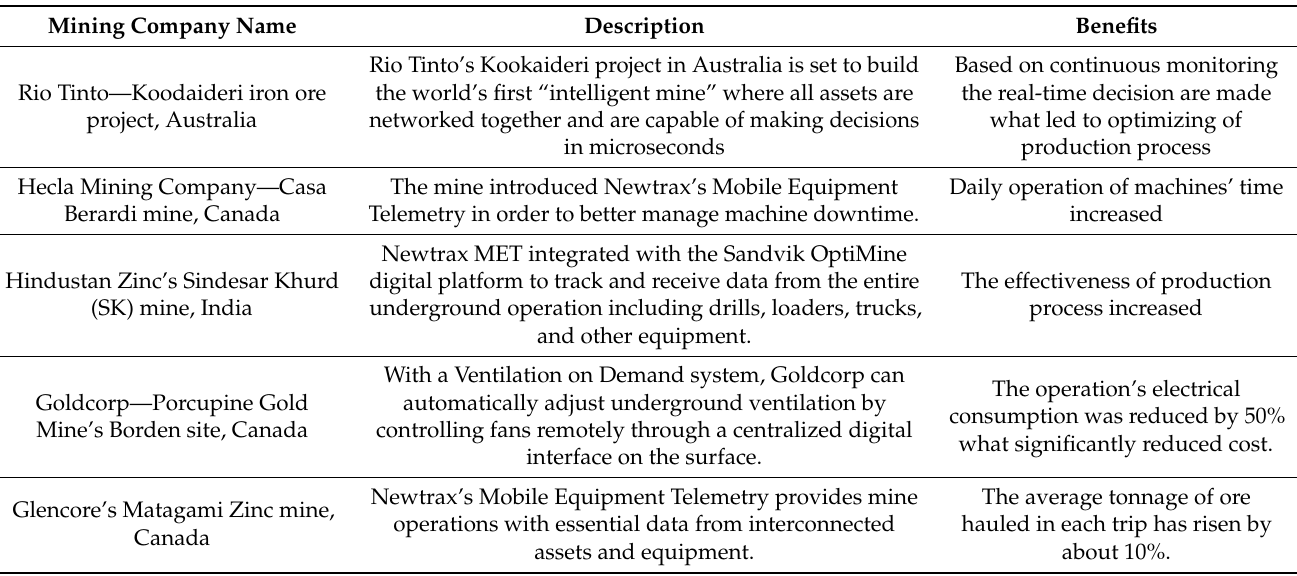
Table 1. Successful cases of IIoT implementation in mining